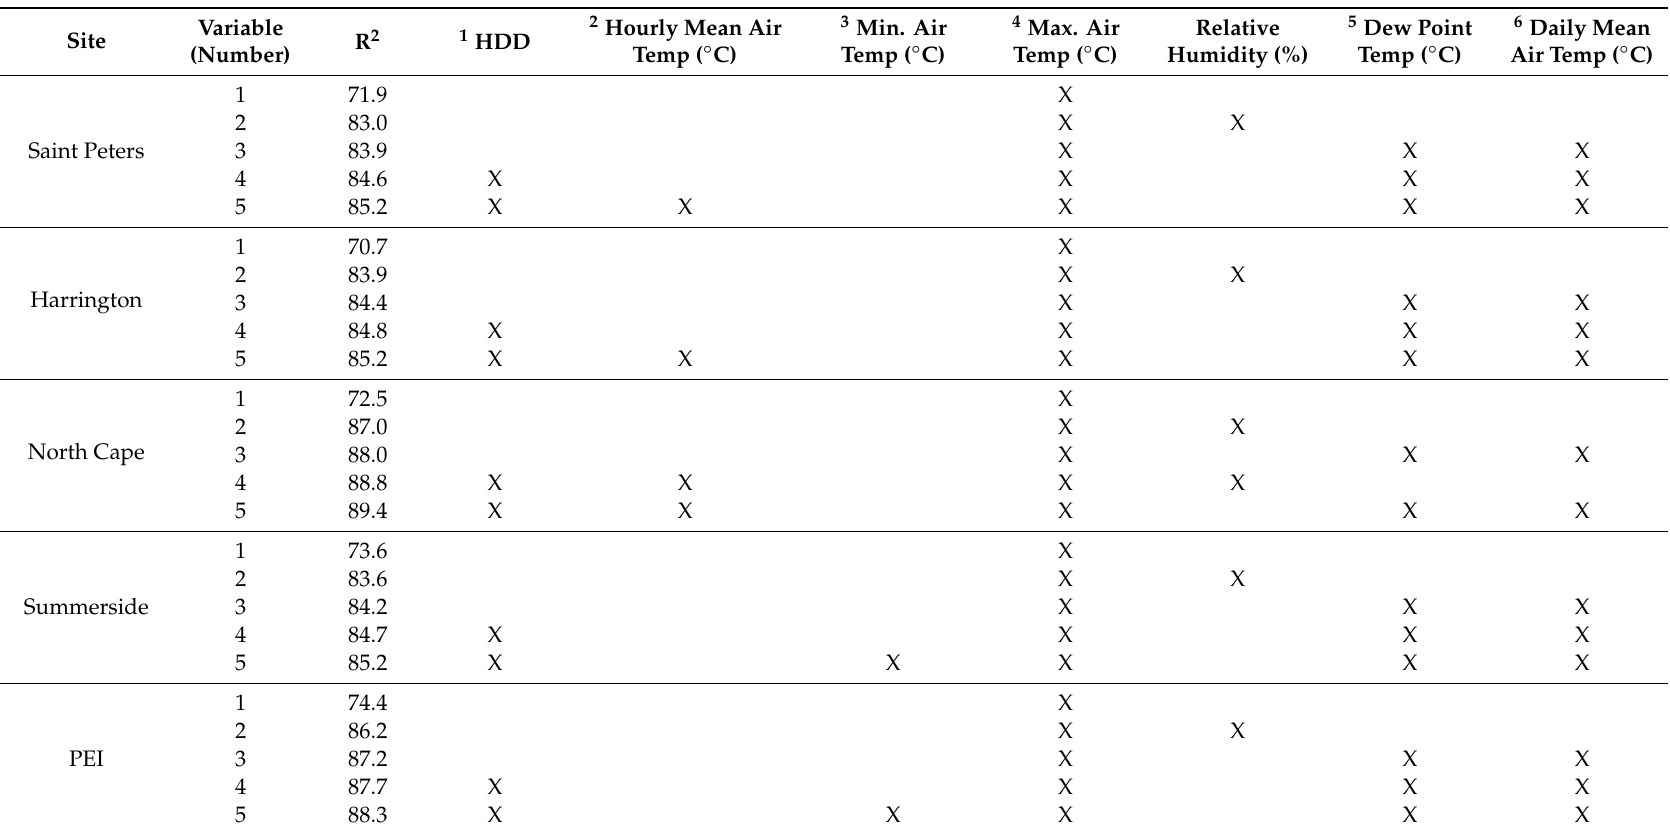
Table 2. Subset regression analysis regressed versus FAO-56 ETo